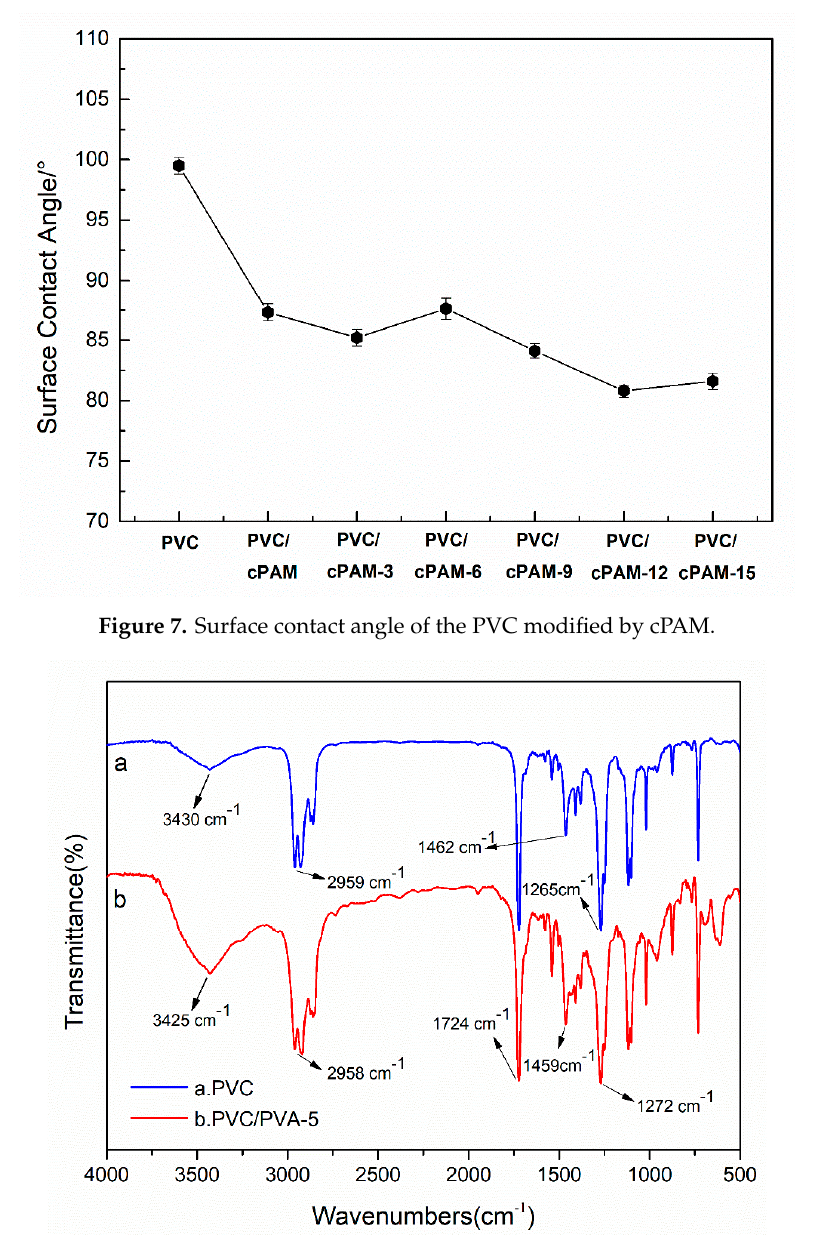
Figure 6. Surface contact angle images of the PVC modified by cPAM: ( a ) PVC, ( b ) PVC/cPAM, ( c )